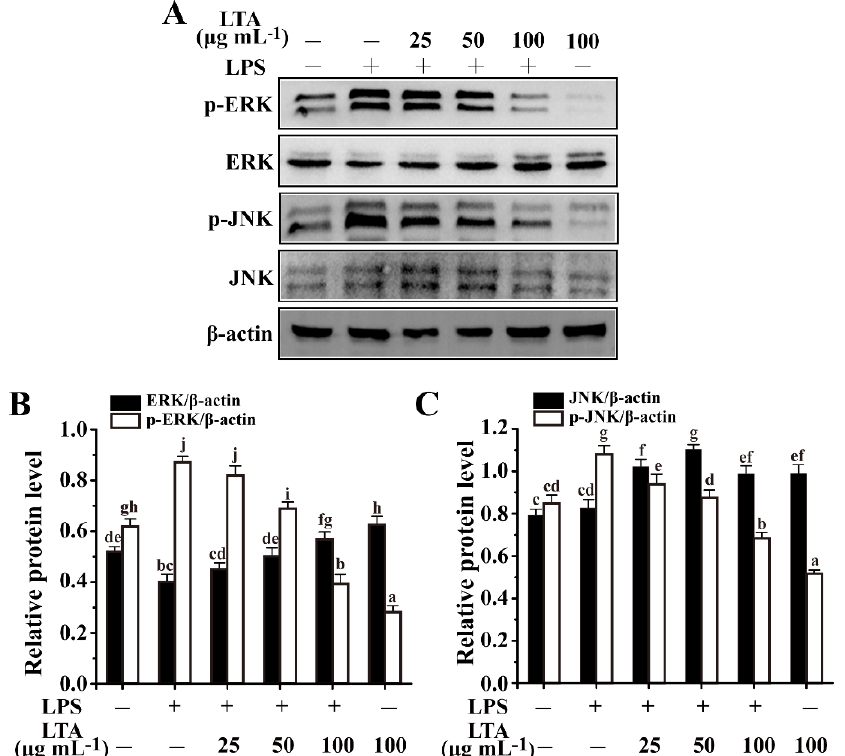
Figure 4. LTA attenuated MAPK signaling in LPS-induced RAW264.7 cells. ( A ) Phosphorylation of ERK and JNK MAPK was detected through Western blotting analysis. ( B ) Relative protein levels meant the phosphorylation of ERK expression was relative to β -actin and ERK expression was relative to β -actin. ( C ) Relative protein levels meant the phosphorylation of JNK expression was relative to β -actin and JNK expression was relative to β -actin. Values with different letters are significantly different, while same letters indicate no significant difference among the tested strains (Duncan’s test, p < 0.05). “+” and “ − ” mean RAW264.7 cells treated with or without additional LPS or LTA.